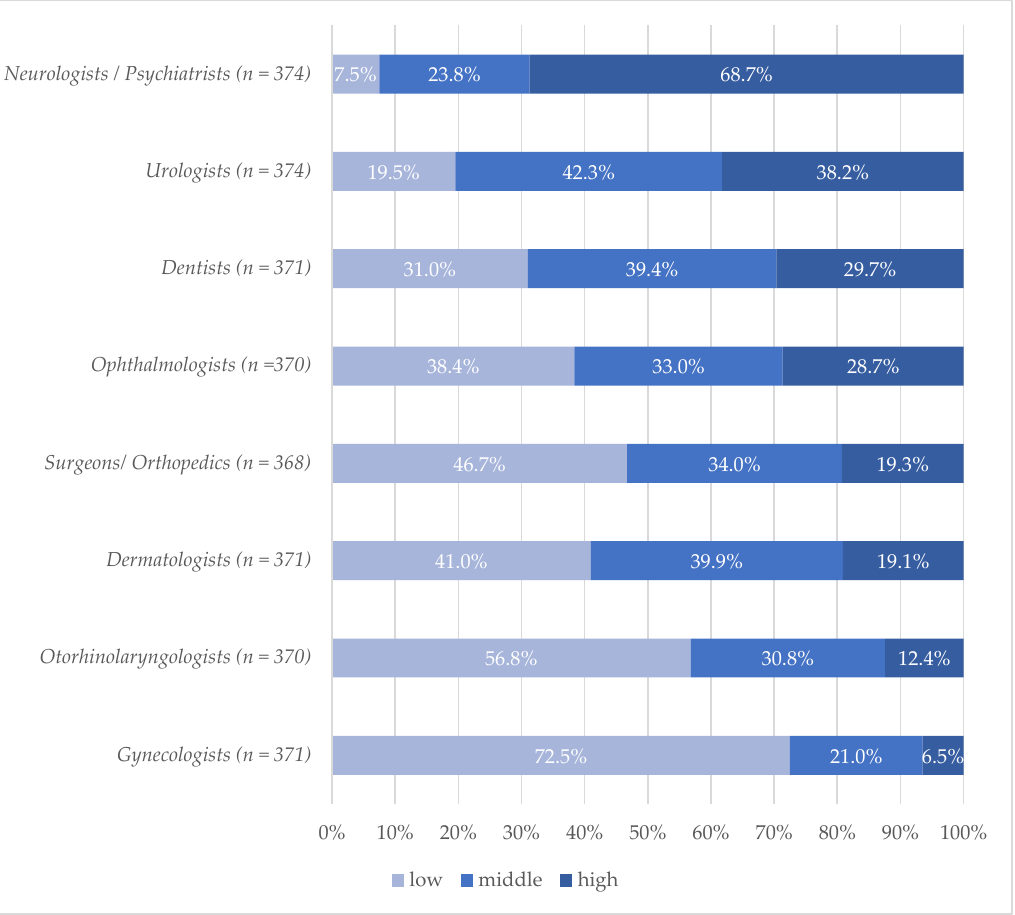
Figure 1. Medical specialist needs of nursing home residents assessed by general practitioners %/differences in n due to missing values. Question: “How do you assess the care needs (of nursing home residents) by different medical specialties?” (Original in German: “Wie schätzen Sie den Versorgungsbedarf durch folgende Arztgruppen ein?”).